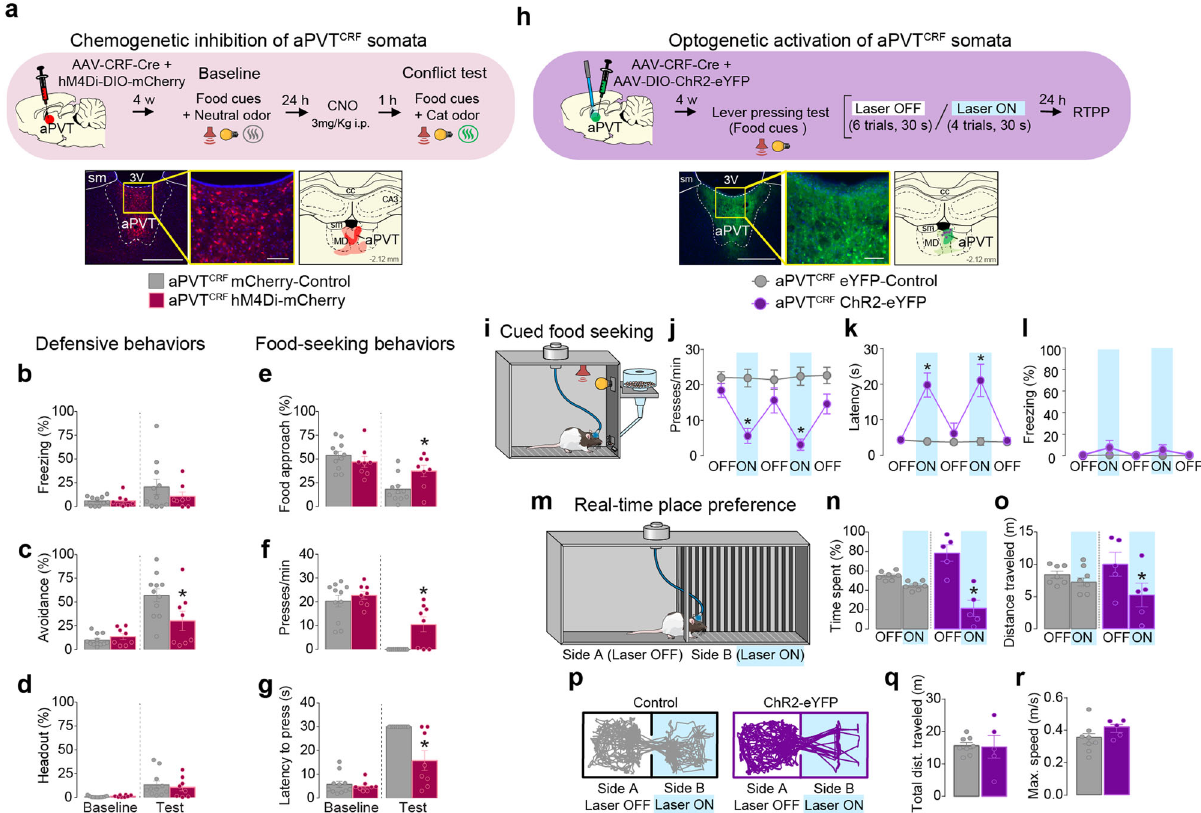
Fig. 5 Activity in aPVT CRF neurons bidirectionally regulates food seeking and avoidance behavior. a (Top) Timeline of the con fl ict test during chemogenetic inhibition of aPVT CRF neurons. (Bottom left) Representative micrograph showing the viral expression in aPVT. (Bottom center) High magni fi cation of the same micrograph. (Bottom right) Red areas represent the minimum (dark) and the maximum (light) viral expression. b – g Chemogenetic inhibition of aPVT CRF neurons (red wine bars, n = 8) reduced the percentage of time rats spent exhibiting c avoidance ( F (1, 17) = 6.41, P = 0.021), and increased e food-approach time ( F (1, 17) = 13.9, P = 0.0017) and f lever presses ( F (1, 17) = 4.62, P = 0.046), with a reduction in the g latency to press ( F (1, 17) = 11.35, P = 0.0036) during the con fl ict test, when compared to mCherry controls (gray bars, n = 11). No changes were observed in b freezing ( F (1, 17) = 0.8813, P = 0.36) and d head-out ( F (1, 17) = 0.34, P = 0.56). h (Top) Timeline of the cued food-seeking test during optogenetic activation of aPVT CRF neurons. (Bottom left) Representative micrograph showing the viral expression in aPVT. (Bottom center) High magni fi cation of the same micrograph. (Bottom right) Green areas represent the minimum (dark) and the maximum (light) viral expression. Purple dots: optical fi ber tips. i